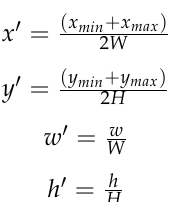
Table 2. UAV detection dataset.